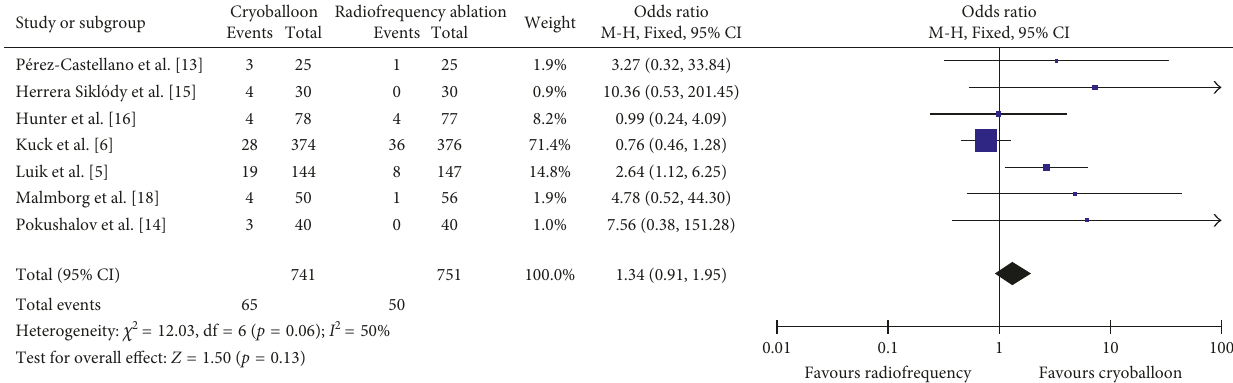
Figure 9: Mean odds ratio of overall postoperative complications with 95% CI in patients receiving cryoballoon versus radiofrequency